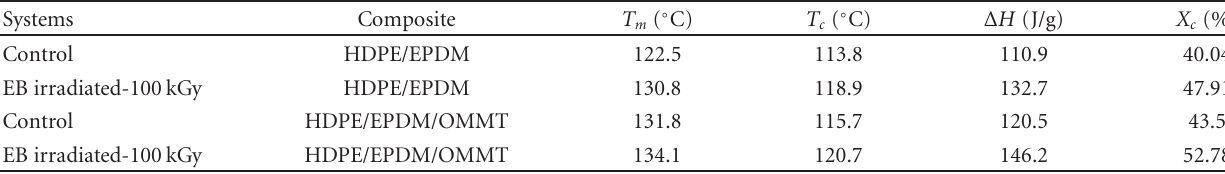
Table 3: DSC Results for unfilled composites and nanocomposite